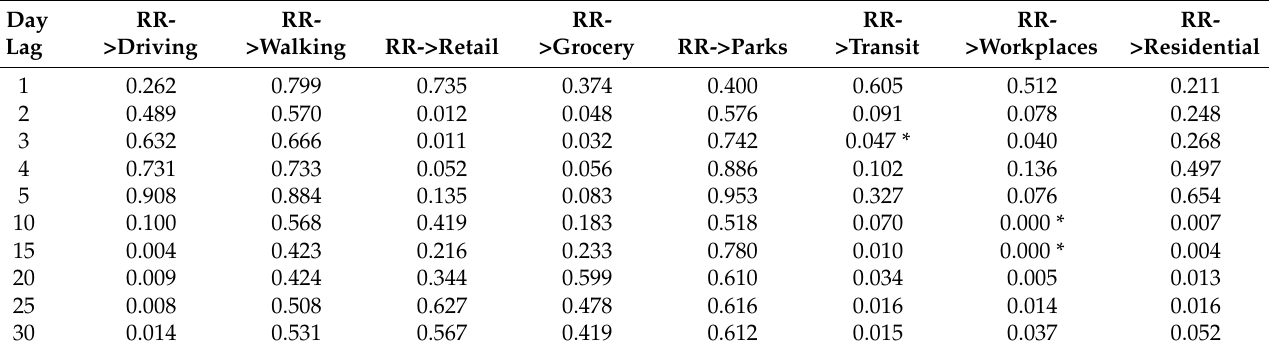
Table A15. Reproduction rate (RR), Granger-cause mobility variables, and p -values in day lags in Poland.